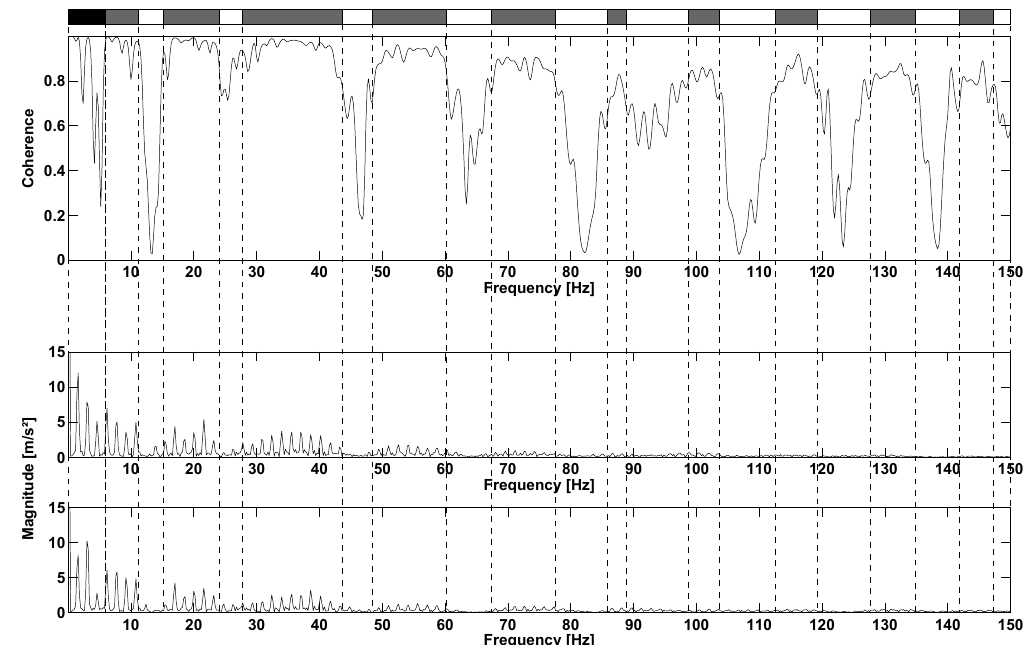
Figure 8. Spectral coherence between R 1344 and H 1344 at 18 km/h: coherence ( top ), H 1344 spectrum ( middle ) and R 1344 spectrum ( bottom ). The black area is the frequency range presenting the stride frequency and first harmonics, white areas are lesser energy ranges and grey areas symbolize the IMUA response to excitation